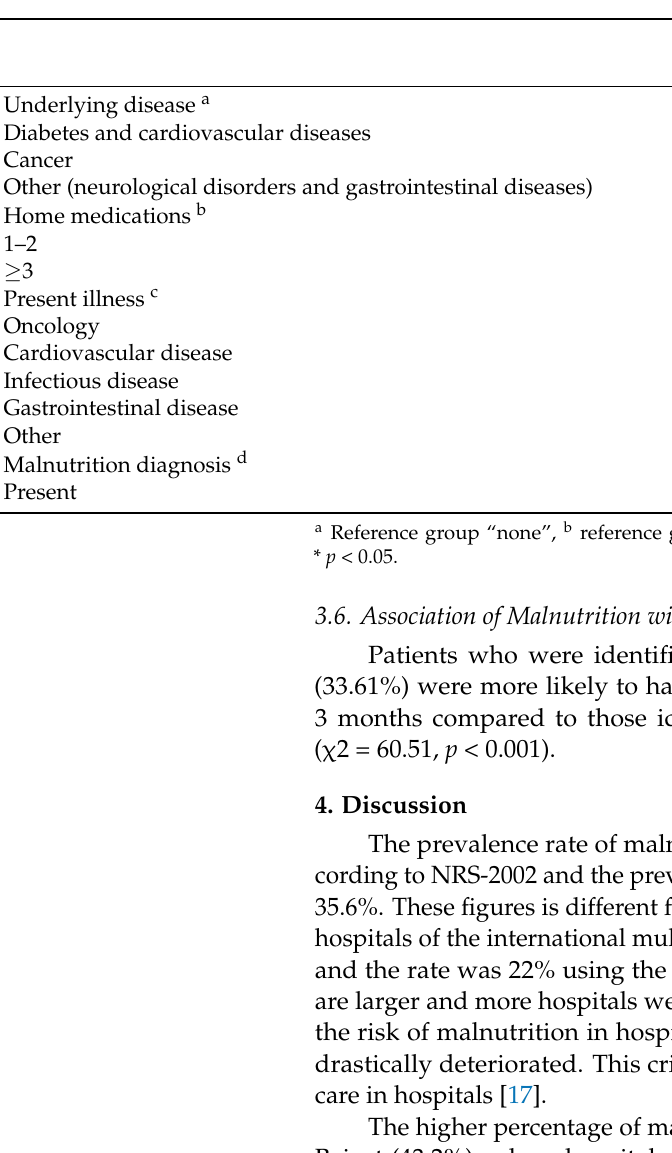
Table 5. Multiple logistic regression models for length of